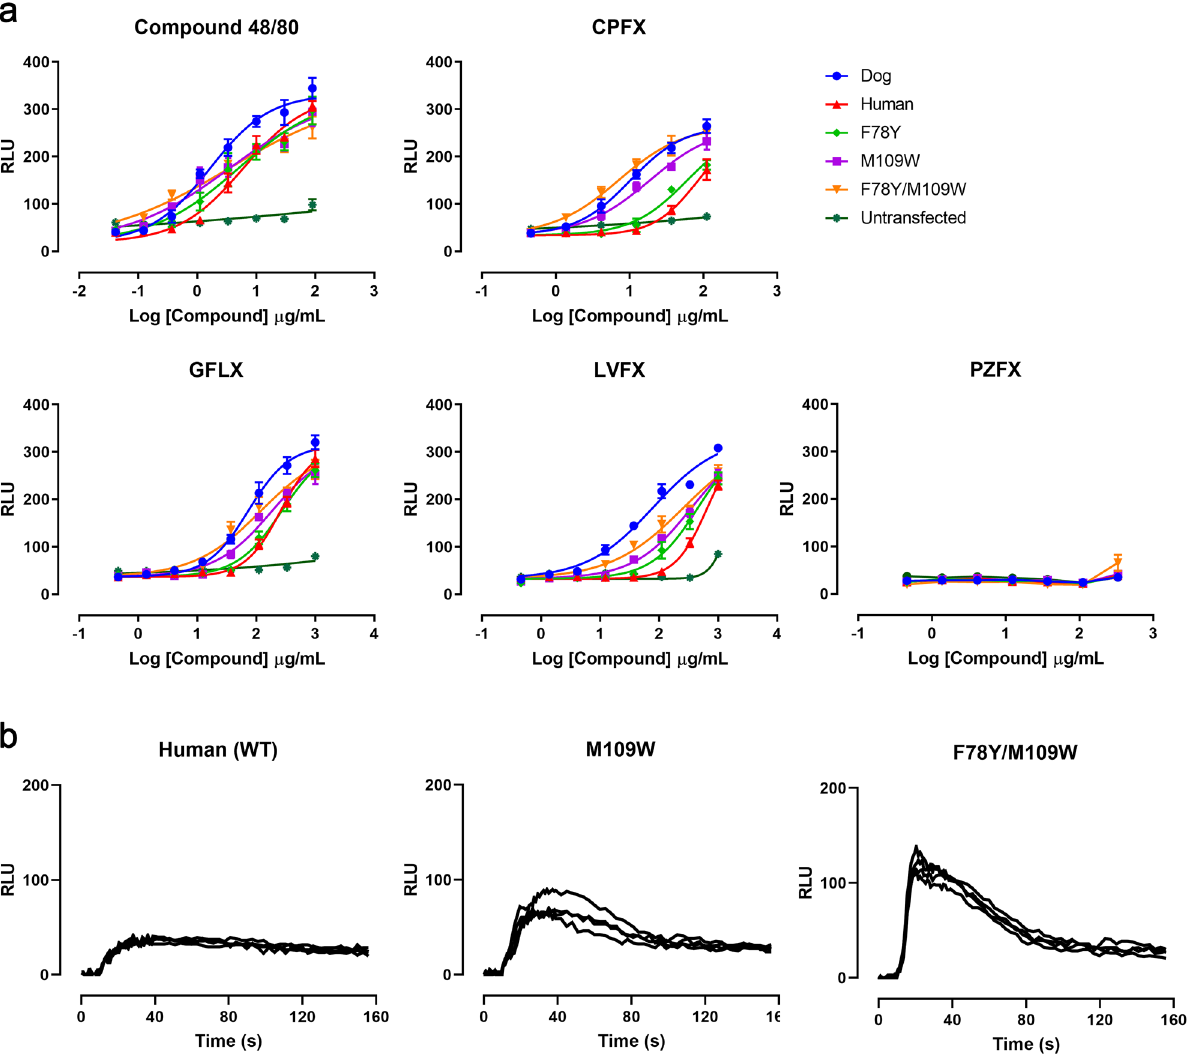
Figure 3. Effects of test articles on changes in intracellular calcium levels in cells expressing human MRGPRX2 or its mutant. HEK293 cells transiently transfected with dog MRGPRX2, human MRGPX2, or a mutant of human MRGPRX2 exposed to compound 48/80 or fluoroquinolones [ciprofloxacin (CPFX), gatifloxacin (GFLX), levofloxacin (LVFX), and pazufloxacin (PZFX)]. ( a ) Dose-dependent responses of intracellular calcium levels. Data are presented as the mean ± S.D. of quadruplicate assays. The four-parameter sigmoidal model was used for curve-fitting. Untransfected HEK293 cells were used as a negative control. ( b ) Time-course changes of intracellular calcium levels in cells expressing human MRGPRX2 WT or its mutant. Traces show representative intracellular calcium fluctuation following exposure to CPFX (4.1 µg/mL). Test articles were perfused from 10 s. RLU relative light units, s